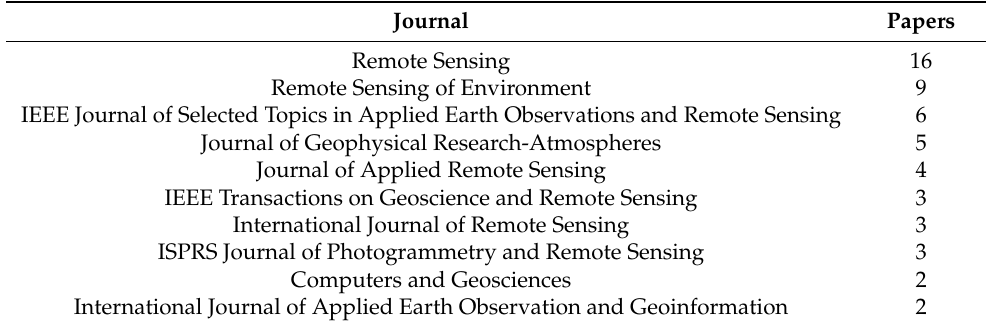
Table 1. Top 10 journals with the highest number of publications.